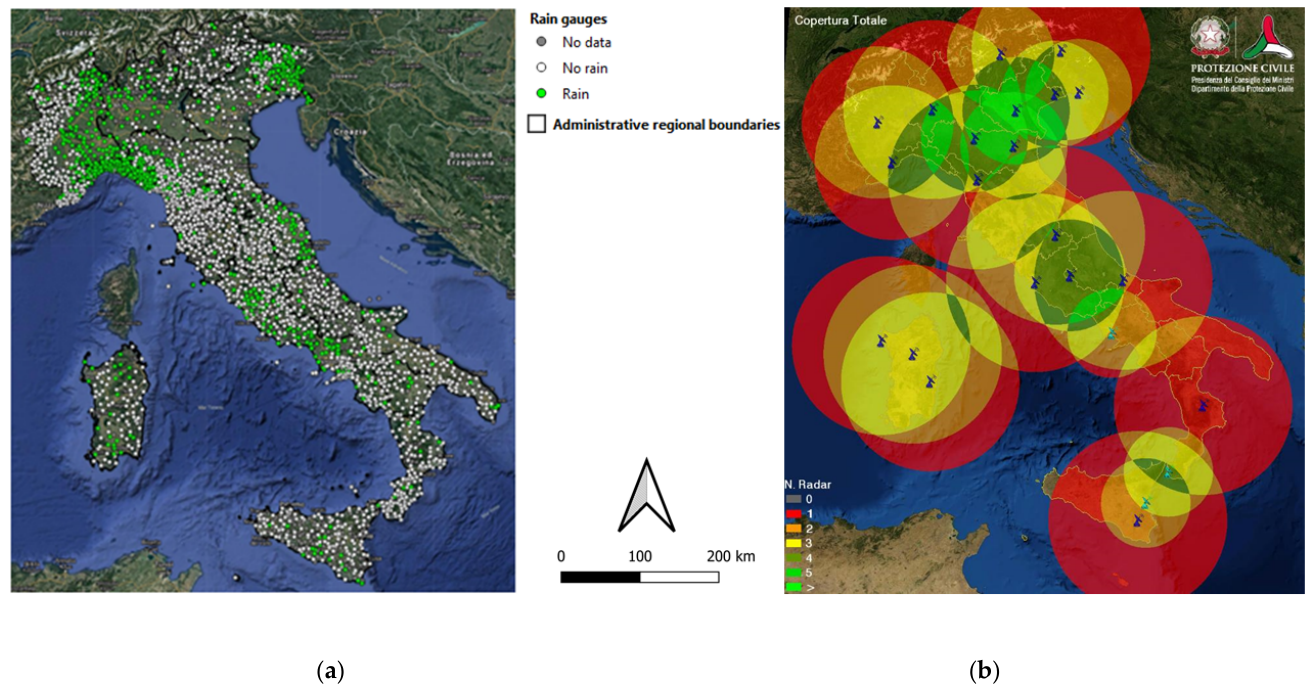
Figure 2. Italian rain-gauge network ( a ) and radar network ( b ). In ( b ), blue radar icons refer to C-band radars, while light blue ones to X-band radars. Table 1. Characteristics of radars composing the Italian radar network.